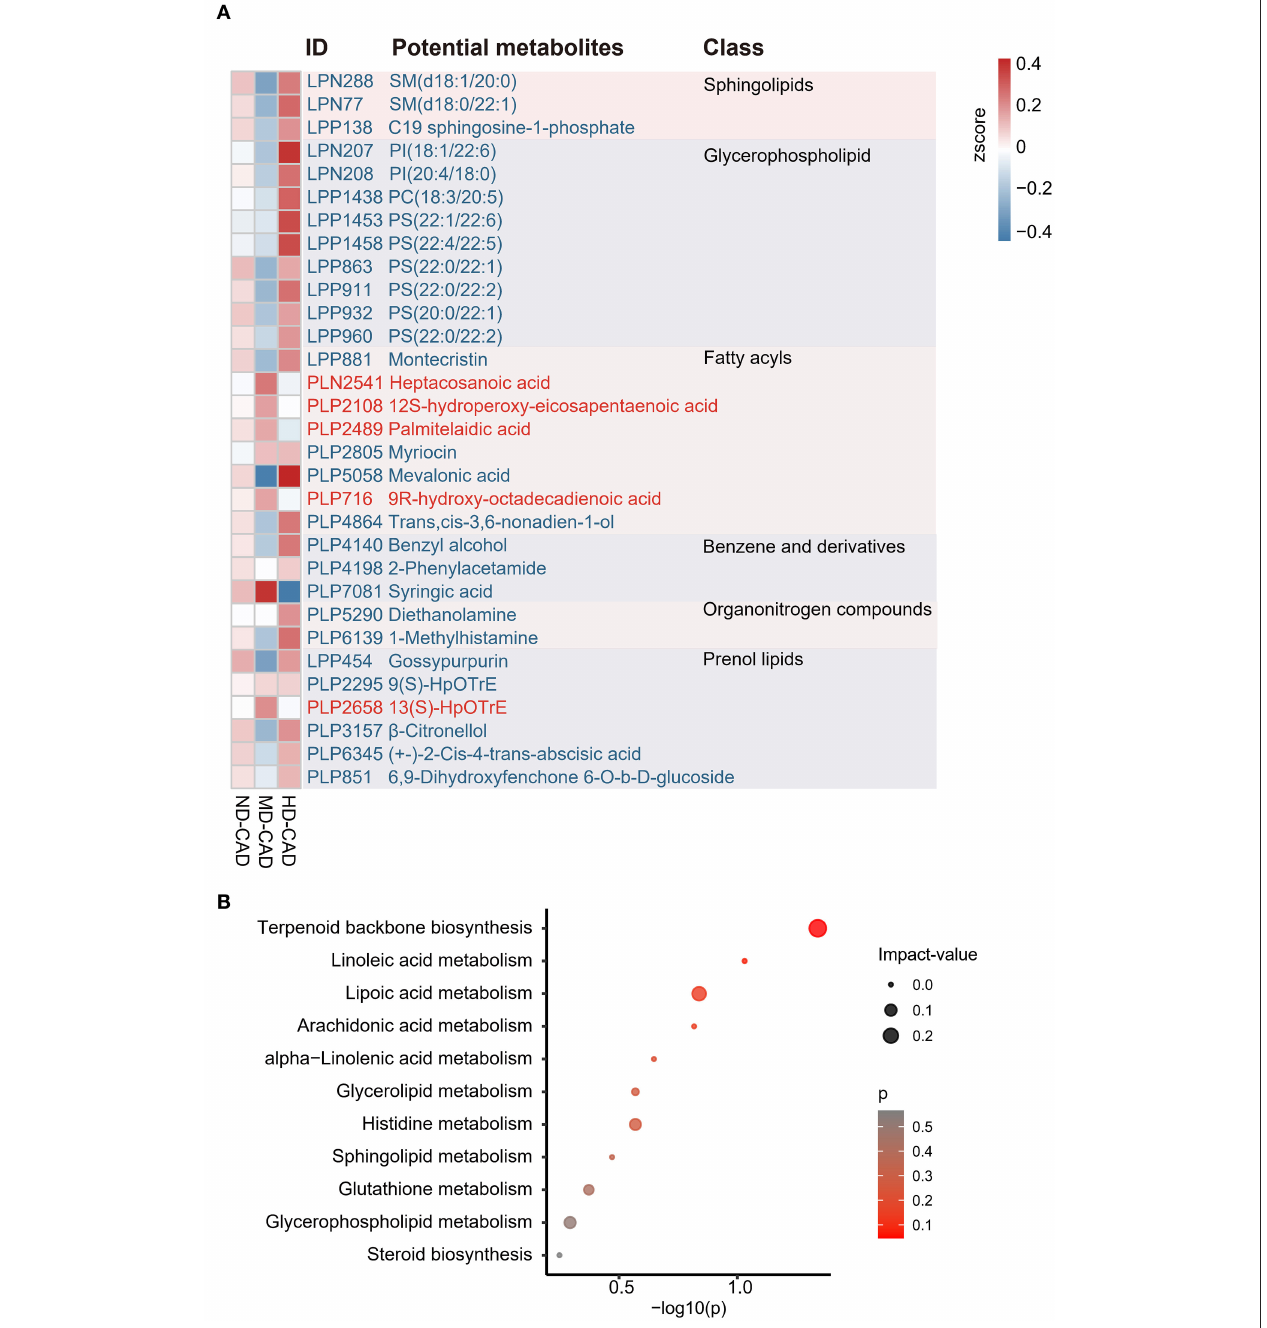
FIGURE 2 | Identification of the key metabolites associated with alcohol consumption in patients with CAD. (A) Heatmap showing part of the key metabolites associated with moderate alcohol consumption across three groups with CAD. (B) Bubble map demonstrating the potential metabolic pathways associated with moderate alcohol consumption using MetaboAnalyst. The IDs and the annotated potential metabolites are highlighted in red (enriched in MD-CAD) or blue (depleted in MD-CAD).